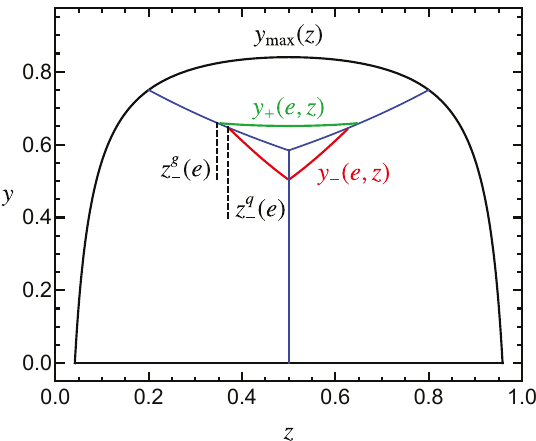
Figure 10 . Phase-space diagram in ( z; y ) coordinates (black curves) split by blue lines into regions in which the thrust axis points in the direction of the quark, anti-quark or gluon momenta. In green and red we show the contour lines for constant value of (cid:28) E corresponding to the functions y + ( e; z ) and y (cid:0) ( e; z ), respectively. The two curves do not meet at any point, but intersect with the boundary separating the gluon and quark regions at the points z q dashed black lines. To generate this plot the parameters ^ m = 0 : 2 and (cid:28) E = 0 : 27 were